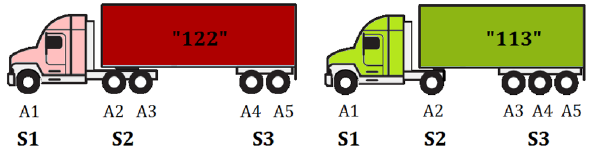
Fig. 6 Main types of axles groups and their induced